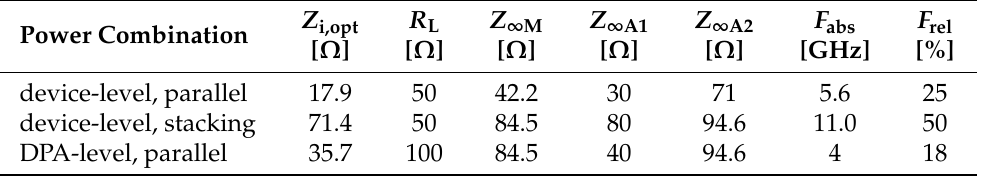
Figure 6. Schematics of the three analyzed on-chip power combination strategies applied to the DPA combiner of Figure 4: ( a ) devices in parallel, ( b ) devices in series (stacked), ( c ) DPAs in parallel. Table 5. Combiner parameters for the different power combination strategies in GaN technology and the corresponding 25% bandwidth estimated by the simplified